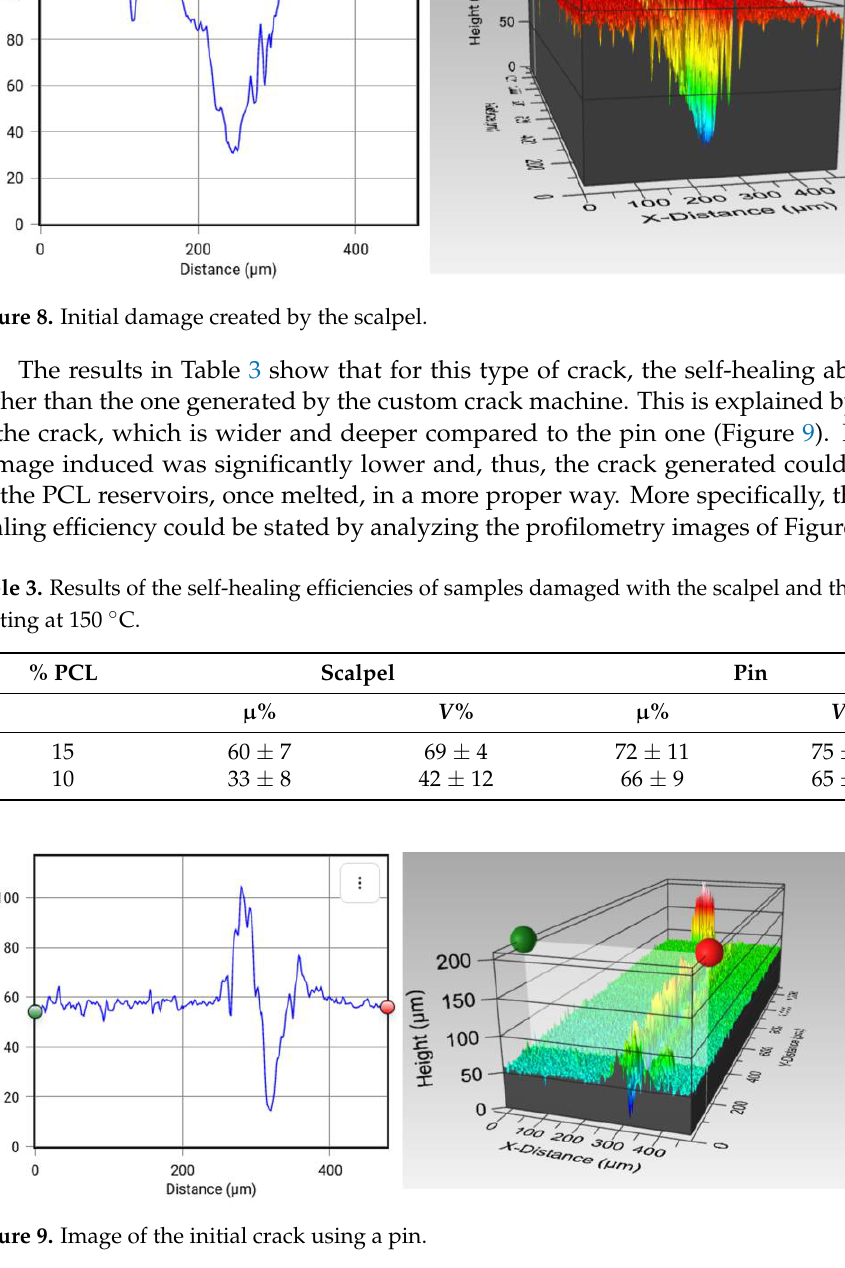
Figure 7. Images of optical profilometry for PCL/epoxy blends with 15% wt PCL before (left image of each pair) and after (right image of each pair) the self-healing process at: ( a ), ( b ) 90 °C, ( c ), ( d ) 110 °C, ( e ), ( f ) 130 °C, ( g ), ( h ) 150 °C.